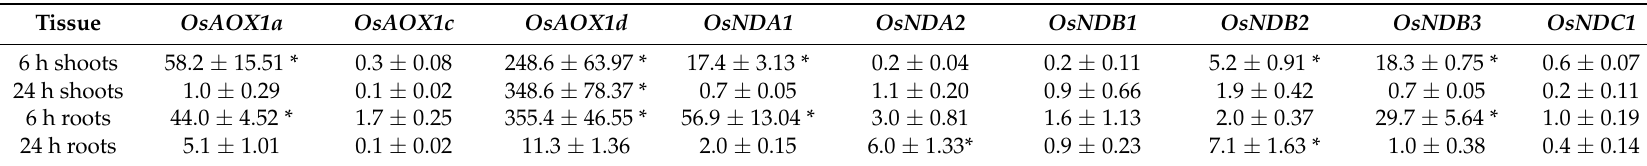
Table 2. Expression of rice AP genes under chemical stress. Exposure to potassium cyanide (5 mM) up-regulates AOX and ND gene expression in rice ( O. sativa ssp. japonica , cv. Nipponbare). Gene expression analyses were carried out using qRT-PCR and transcript levels were determined in both shoot and root tissues exposed to treatments for 6 h and 24 h or grown under control conditions. Data are shown as mean fold change ± SE of three biological replicates relative to the control at each point set at 1.00. * indicates significant transcript level changes relative to the control ( p ≤ 0.05).